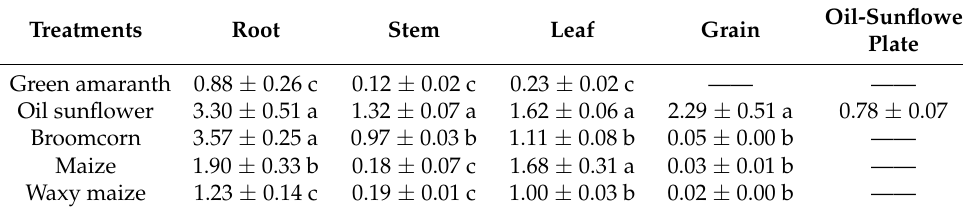
Note: The data are mean ± standard deviation (n = 6), different lowercase letters in the same column indicate significant difference between treatments ( p < 0.05), and dash (——) represents absence of the site.